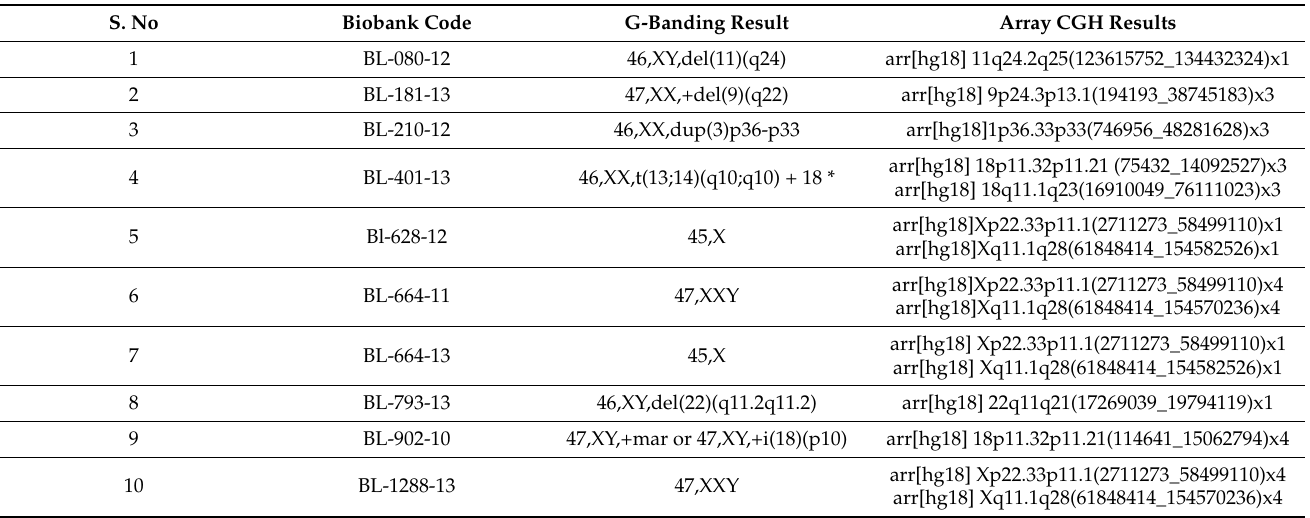
Table 1. Chromosomal abnormalities detected using G-banding and array comparative ge- nomic hybridization in pediatric developmental delay/congenital malformations/intellectual disability patients.